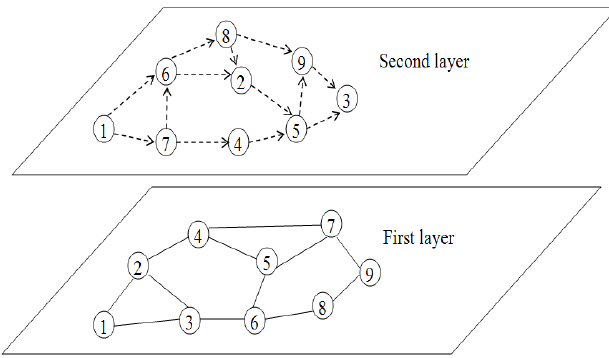
Figure 1. A sample two-layer